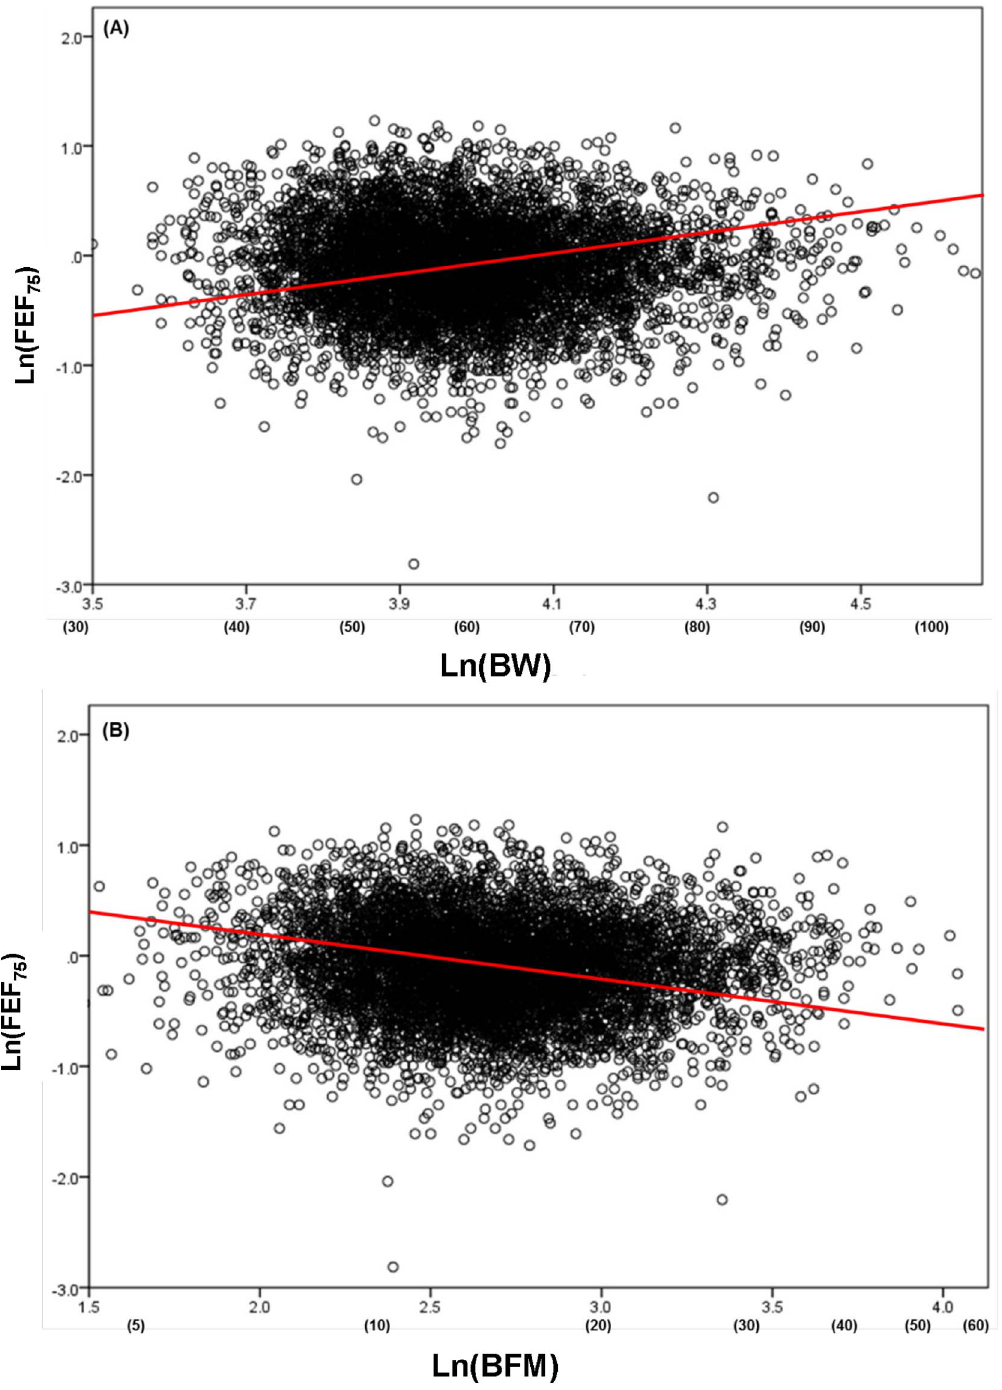
Figure 9. Opposite effects of body weight (BW) and body fat mass (BFM) on FEF 75 in female middle-age group. (A): Ln(FEF 75 ) vs. Ln(BW). Parentheses: absolute values of BW without log-transformation. Red line: slope of the equation predicting reference means of Ln(FEF 75 ) from Ln(BW), which is equal to partial regression coefficient shown in Table 4 and Fig. 6-(B). (B): Ln(FEF 75 ) vs. Ln(BFM). Parentheses: absolute values of BFM with no log-transformation. Red line: slope of the equation predicting reference means of Ln(FEF 75 ) from Ln(BFM), which is equal to partial regression coefficient given in Table 4 and Fig. 8-(B).